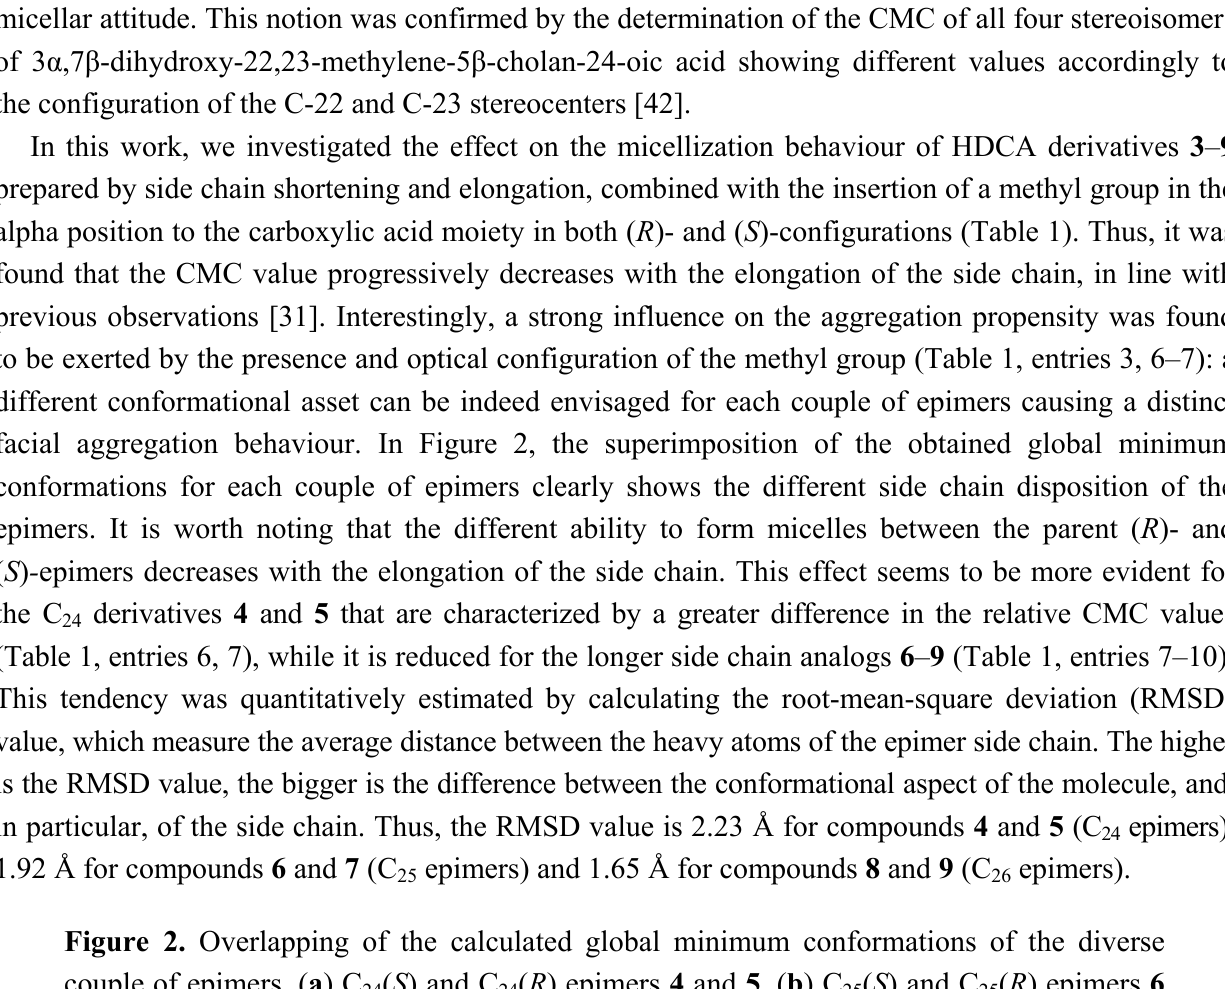
( S ) and C ( R ) epimers 6 25 25